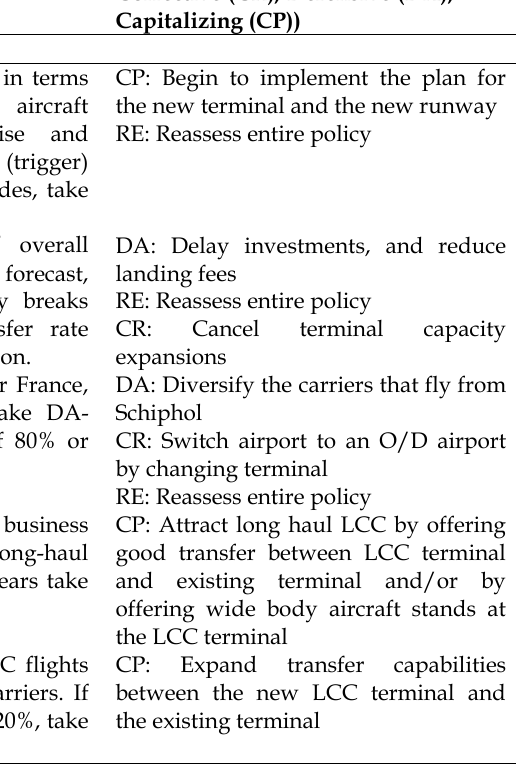
Table 4. Contingency Planning Vulnerabilities and